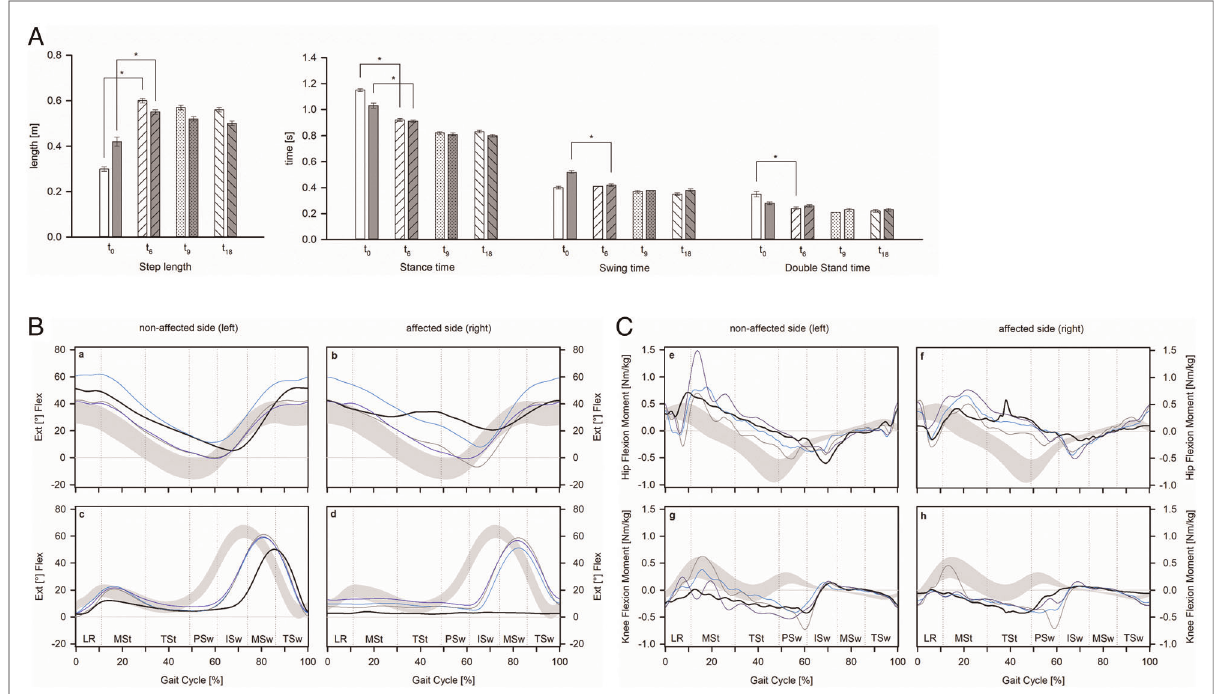
FIGURE 3 Spatio-temporal parameters of gait ( A ), kinematics ( B ), and kinetics ( C ) of hip and knee joints prior to transfemoral amputation and during the follow- up period. ( A ) Open and fi lled bars represent the non-affected and affected side prior to surgery ( t 0 ) as well as 6 ( t 6 ), 9 ( t 9 ), and 18 ( t 18 ) months after. ( B ) Kinematics of the hip (a,b) and knee joints (c,d) together with the normal range [gray area (24)] are presented prior to transfemoral amputation (black) as well as 6 (light blue), 9 (gray), and 18 (dark blue) months after switching to transcutaneous osseointegrated prosthesis system (TOPS). ( C ) Kinetics of the hip (e,f) and knee joints (g,h) together with the normal range [gray area (24)] are presented prior to transfemoral amputation (black) as well as 6 (light blue), 9 (gray), and 18 (dark blue) months after switching to TOPS. Vertical lines indicate the phases of the gait cycle, that is, LR, loading response; MSt, mid stance; TSt, terminal stance; PSw, pre-swing; ISw, initial swing; Msw, mid-swing; TSw, terminal swing